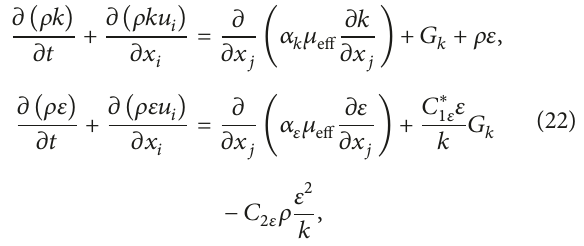
200 m long tunnel. In order to simulate the effects of the unmodeled section on results, the extrapolation method of flow field parameters was used at the end of the model